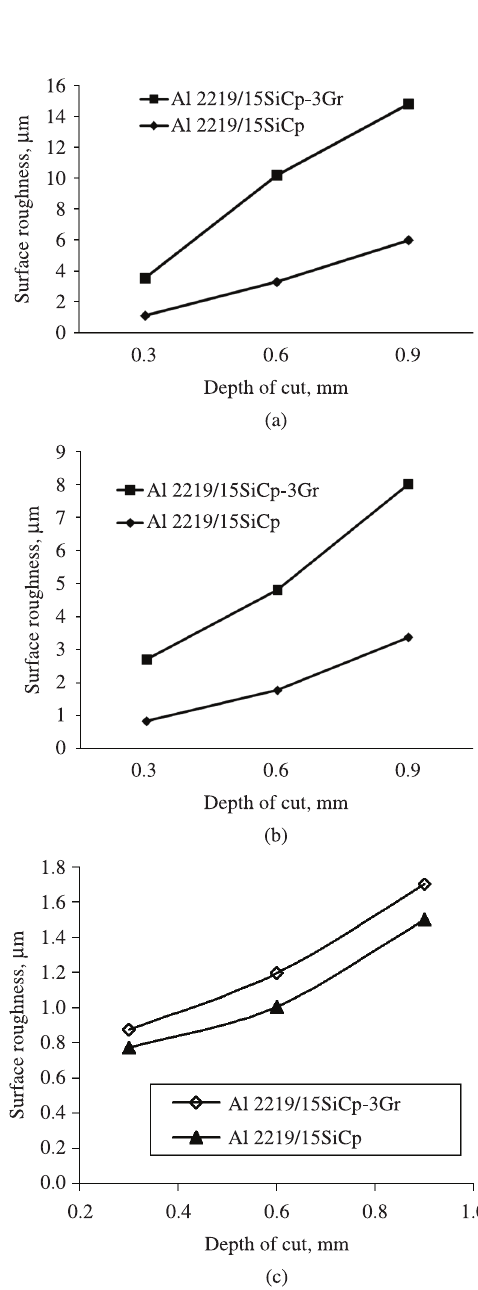
Figure 2. Variation of surface roughness (Ra) with feed rate for both the composites at a constant cutting distance of 50 mm, cutting speed of 80 m/min, depth of cut of 0.3 mm (a) carbide tool (b)Coated Carbide tool and (c)PCD tool.